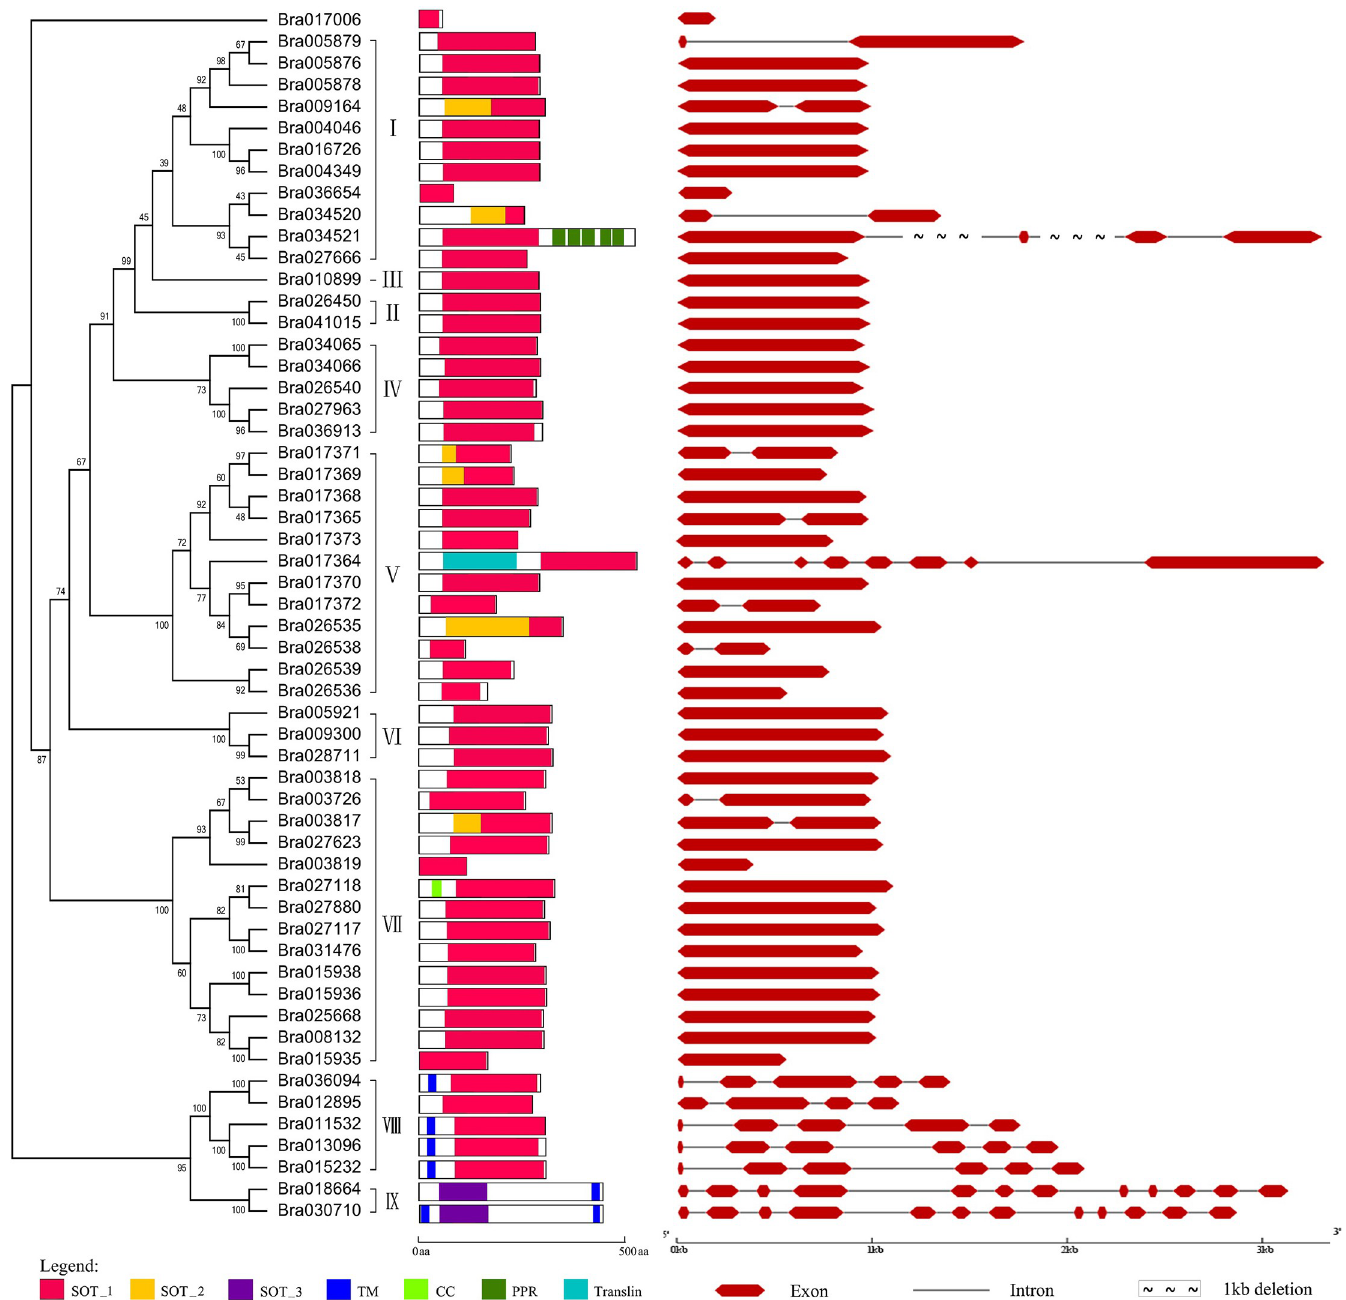
Fig 3. Conserved domains and gene structure of the sulfotransferase (SOT) family in Brassica rapa . Left panel: Neighbor-joining tree showing phylogenetic relationships of 56 BraSOT protein family members. Roman numerals correspond to the nine recognized groups of SOT genes. Numbers above and below branches are bootstrap percentages. Middle panel: Conserved domains in BraSOTs. The SOT_1 domain represented by a yellow bar is a second copy of the SOT_1 domain. Abbreviations: TM, transmembrane; CC, coiled-coil. Right panel: Exon–intron structure of BraSOT genes drawn with GSDS v2.0. Red bars and lines represent exons and introns,